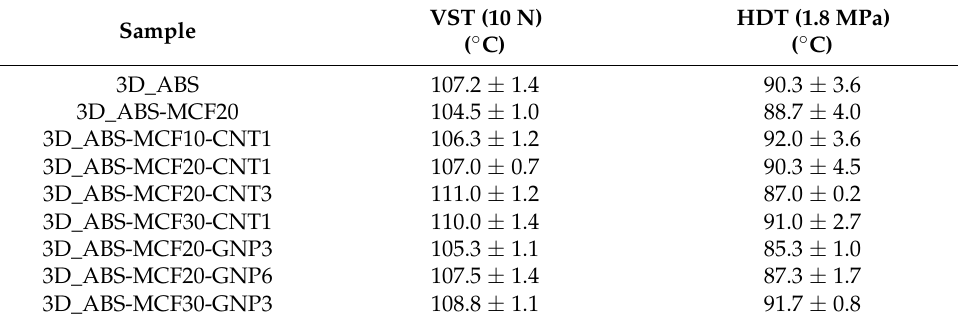
Table 8. Vicat softening temperature (VST) and Heat deflection temperature (HDT) of 3D-printed pure ABS and selected multiscale